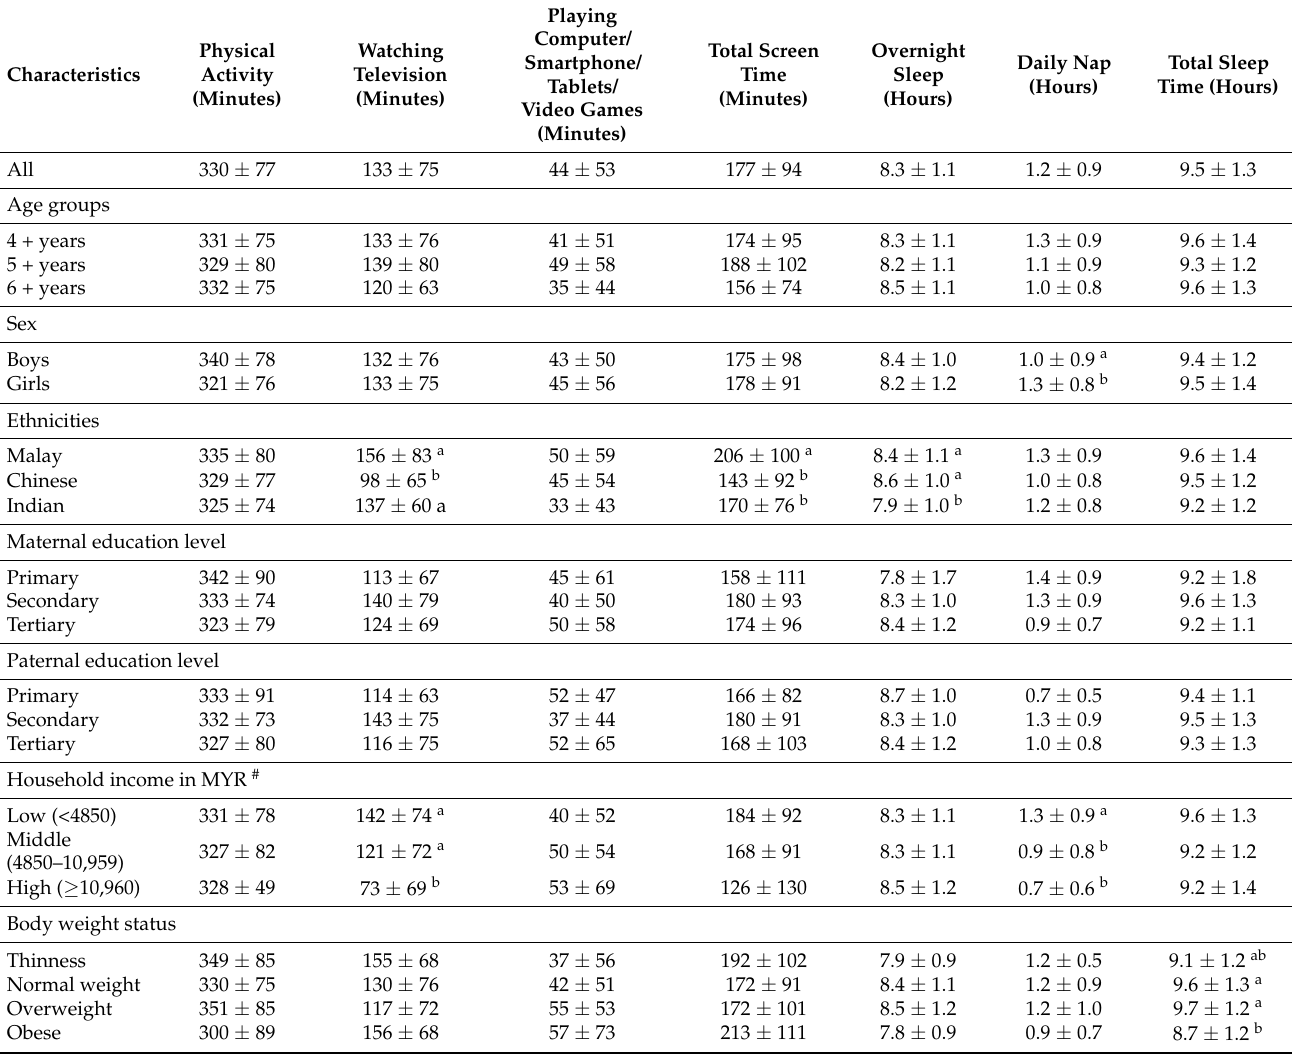
Table 2. Mean time spent on physical activity, screen activities and sleep (mean ±